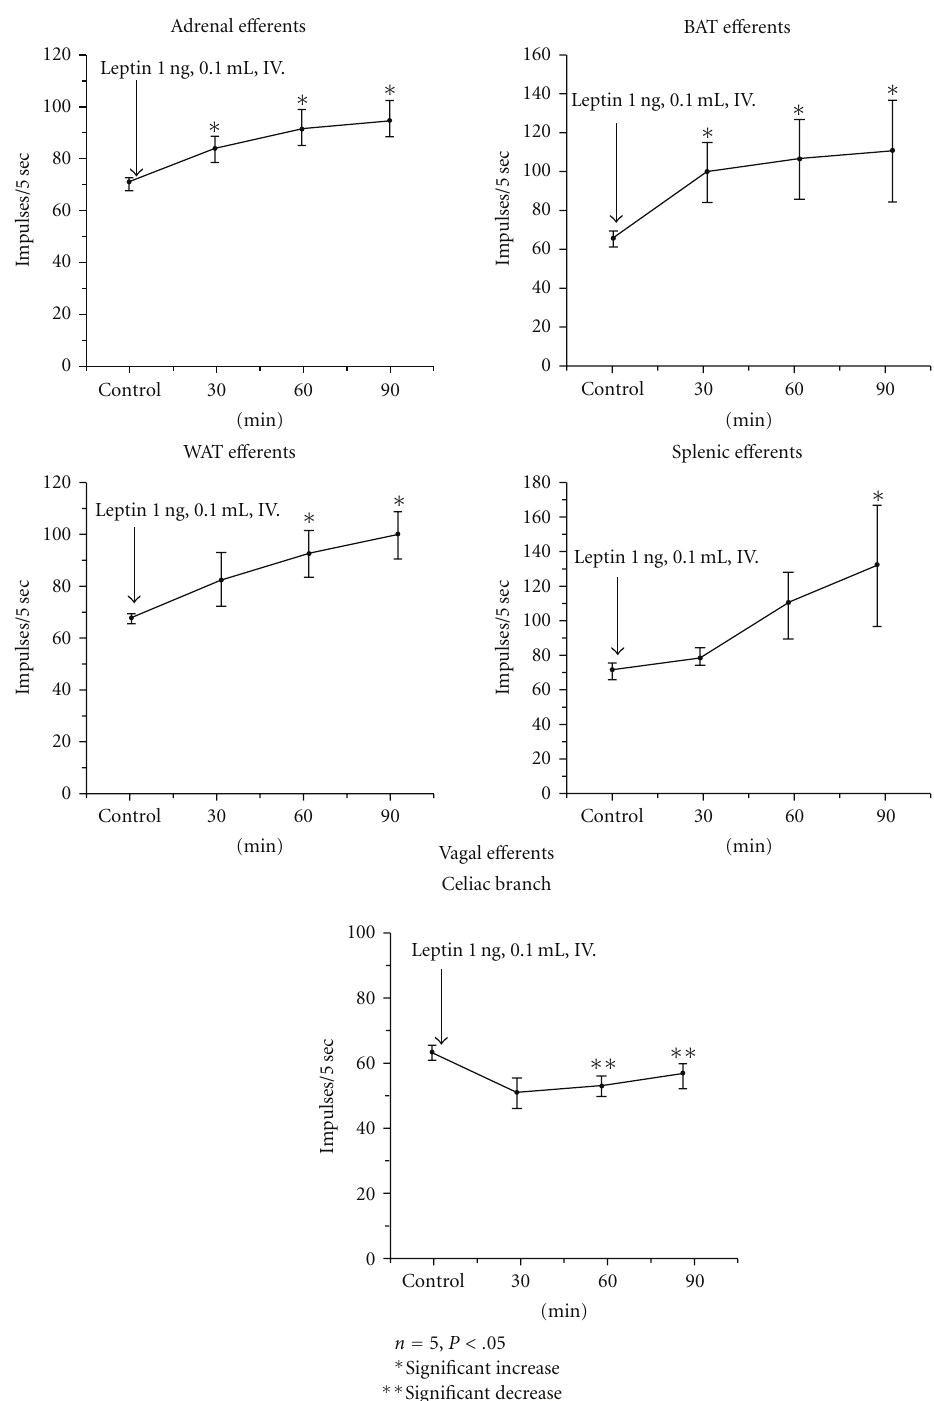
Figure 4: Reflex e ff ects of IV injection of leptin (1nfg, 0.1 mL) on the mean discharge rates of sympathetic and vagus nerve.